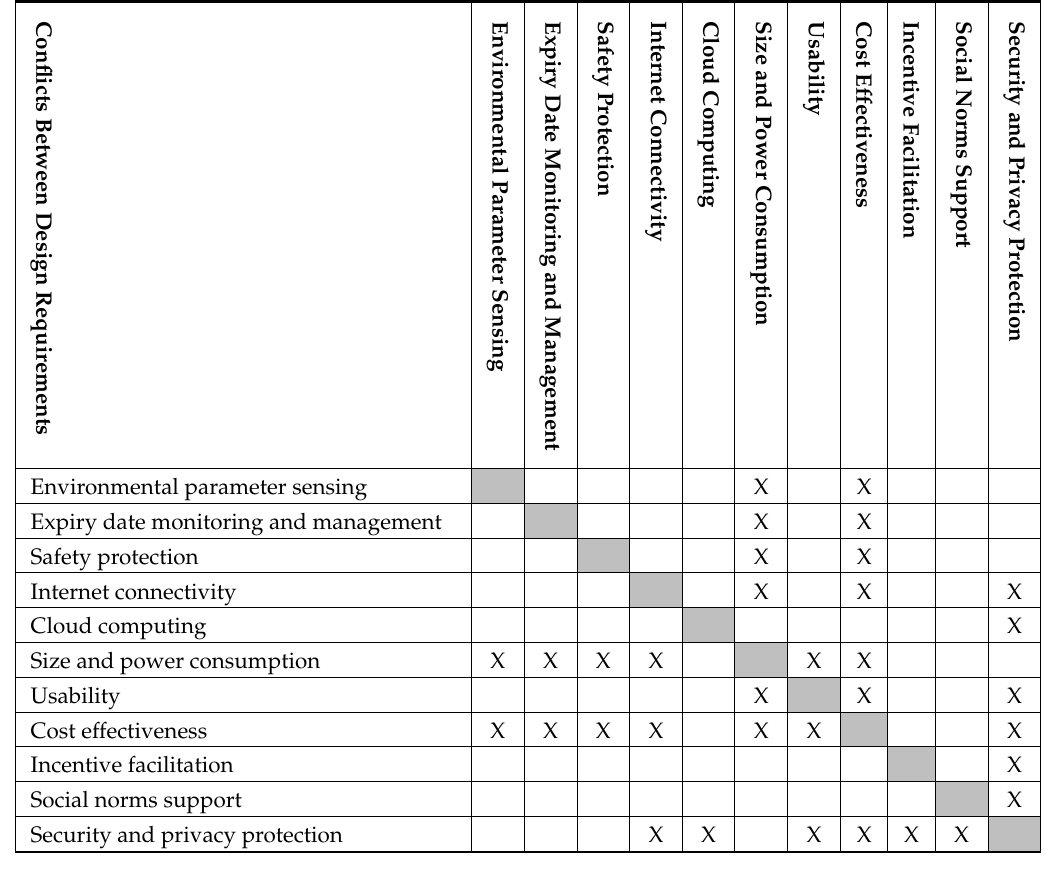
Table 3. Conflicts between proposed design requirements for developing the ReMINDS ecosystem (a “X” symbol illustrates a conflict between the column and row